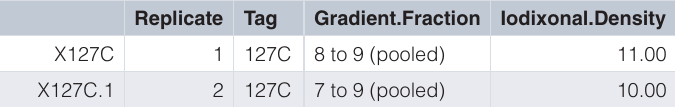
Table 1. Differences in gradient fraction